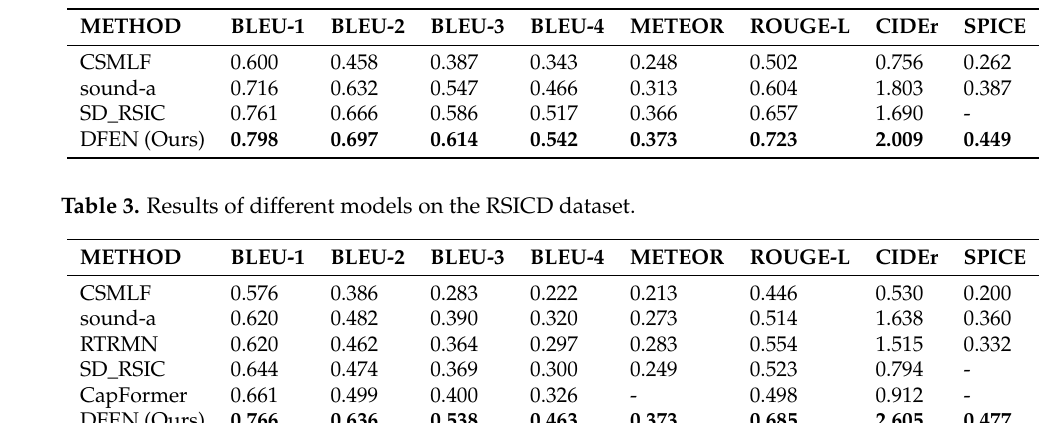
Table 2. Results of different models on the Sydney-caption dataset.